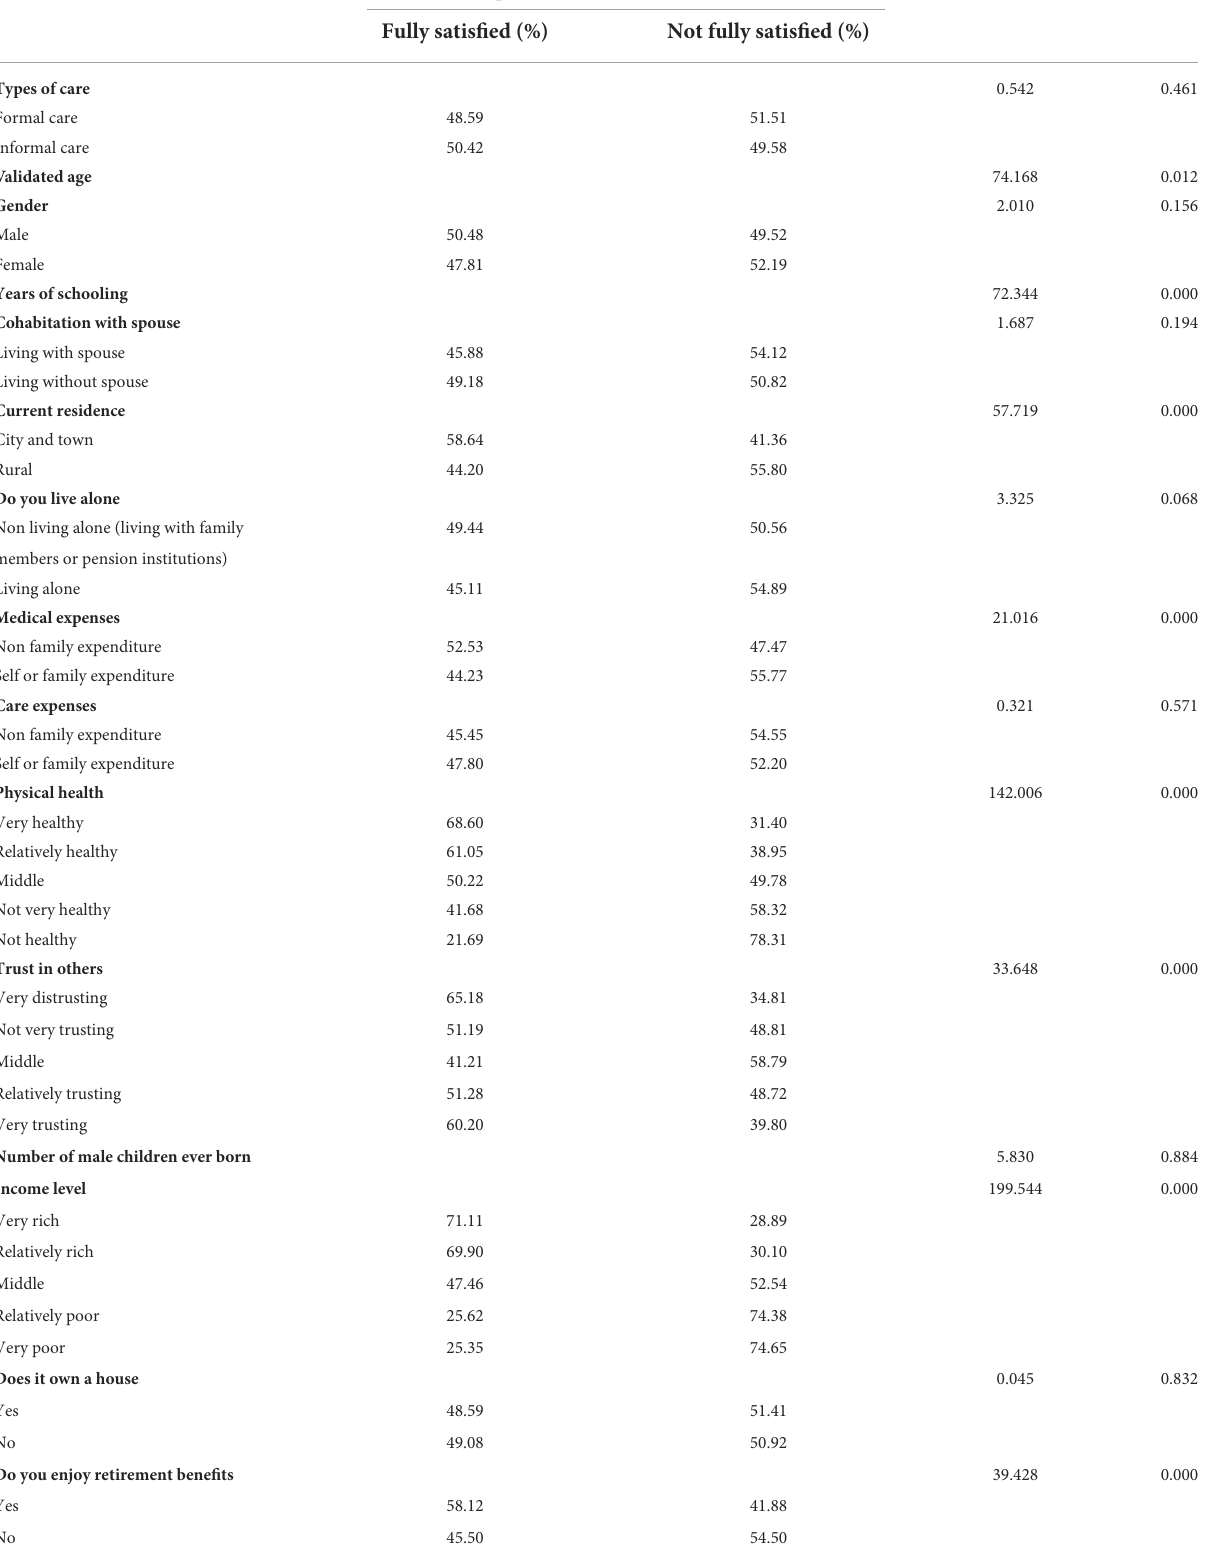
TABLE 2 Care effects on older people with disability of different characteristics.